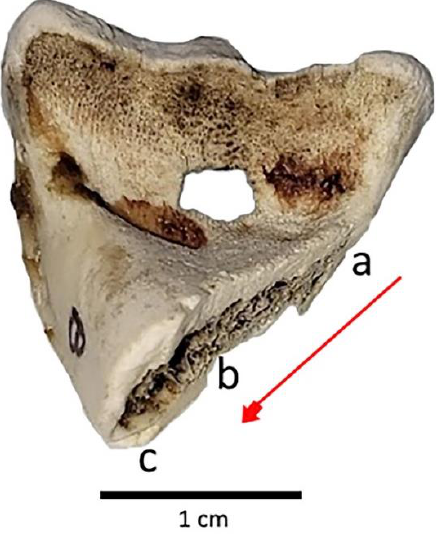
Figure 8. Class 5 chop mark made by the bronze axe on deer humerus (cBI 26); (a) place of impact (beginning of sheared surface), (b) kerf fracture (end of sheared surface), and (c) controlled break- age. The arrow indicates the direction of the axe.